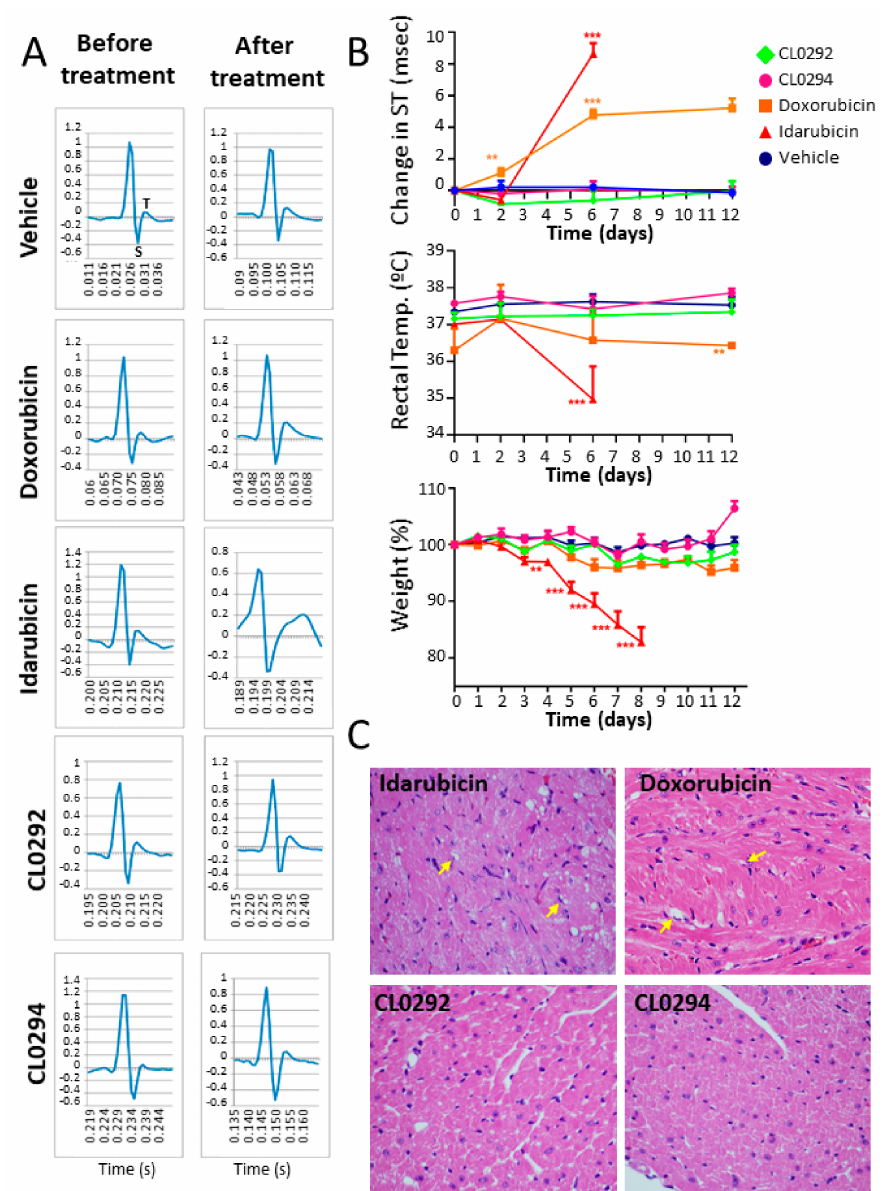
Figure 4. Toxicity assessment in mice. ( A ) Electrocardiograms and ST changes from mice untreated and treated for 6 (Idarubicin) or 12 days (all other compounds) with the indicated vehicle or an- thraquinone compounds from our screening studies. The ST interval reflects the repolarization of the cells and is measured from the deepest valley (S) in the ECG to the top (T) of the round crest that follows. Alterations in the ST interval reflect defects in cardiomyocyte function. ( B ) Evolution of the ST interval values, body temperature and weight changes for the 12 days treatment ( n ≥ 3). As shown, Doxorubicin and especially Idarubicin-treated mice showed marked decreases in body weight and body temperature and these changes were not observed in CL0292 or CL0294 treated rodents. staining of heart tissues from animals treated with the anthraquinone inhibitors isolated in our screen- ing. Doxorubicin treatment was used here as a positive control. Arrows point to cell vacuolization occurring in the left ventricular